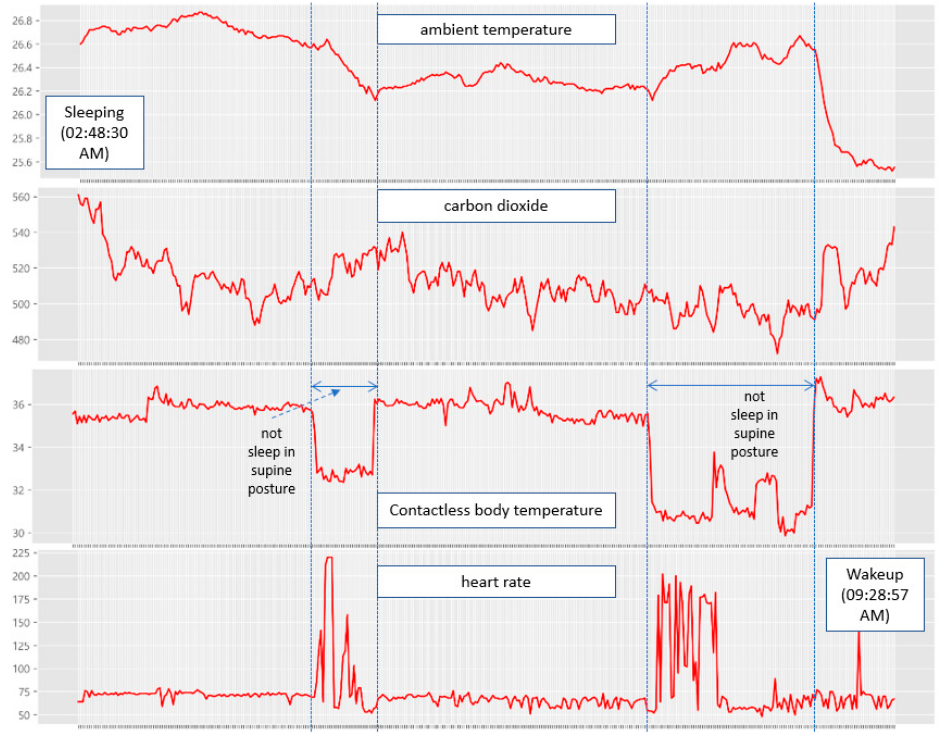
Figure 25. Sleep pattern measurement results of the 27-year-old man.